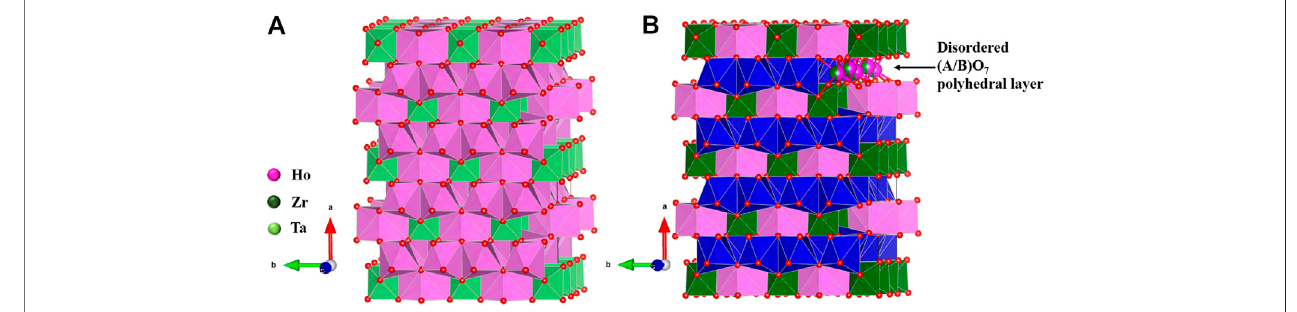
FIGURE 2 | Structure of weberite-type (A) Ho 3 TaO 7 and (B) Ho 2 Zr 2 O 7 , both forming in orthorhombic C222 1 space group. The (A/B)O 7 layer in which partial disorderbetweenAandBcationsismarkedwithbluepolyhedraforclarityin (B) .Figurehasbeendrawnbasedonthecrystallographicdatafromtheliterature(Dreyetal., 2020; Gussev et al., 2020). The crystal structures are drawn using the software VESTA (Momma and Izumi, 2008).